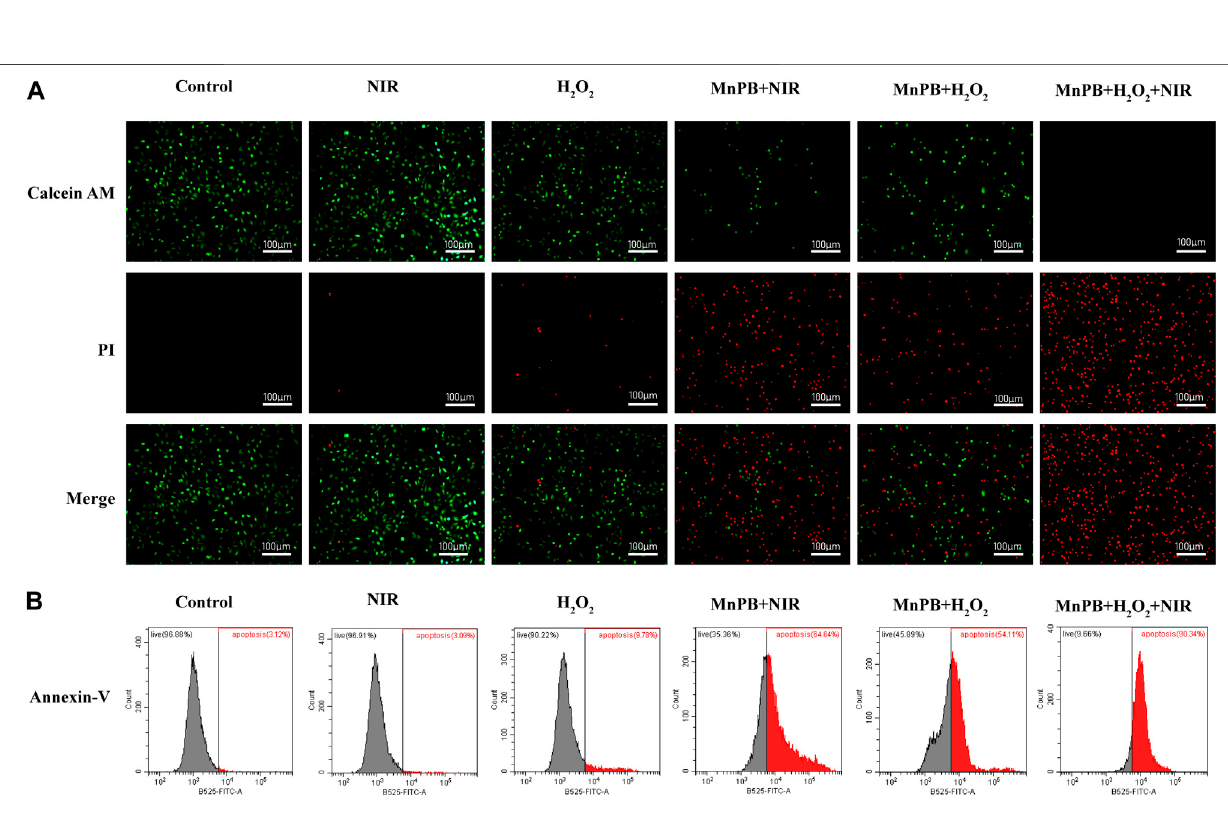
Frontiers in Bioengineering and Biotechnology |